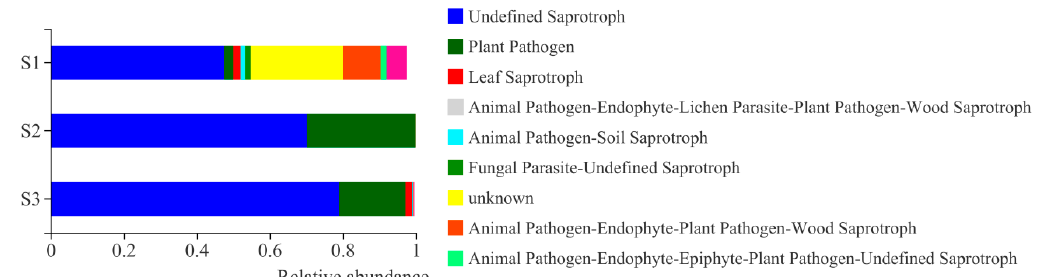
Figure 10. Ecological characteristics of fungi in naturally fermented paocai.